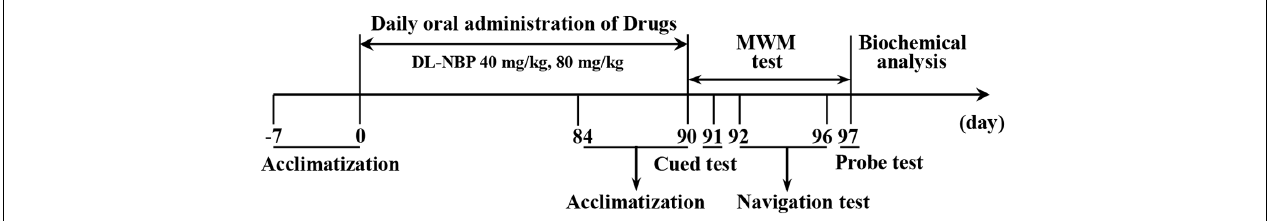
FIGURE 2 | A schematic overview of the behavior and biochemical analysis in the study.